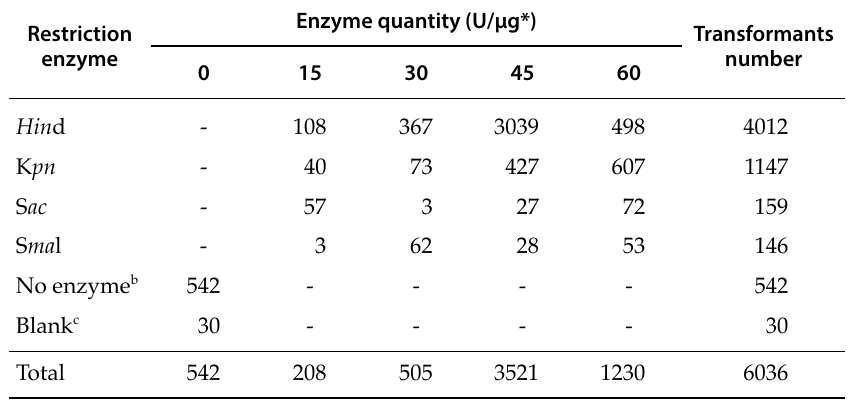
Table 1. Number of Lasiodiplodia theobromae transformants obtained with different enzyme quantities by REMI. Enzyme quantity (U/μg*) Restriction enzyme